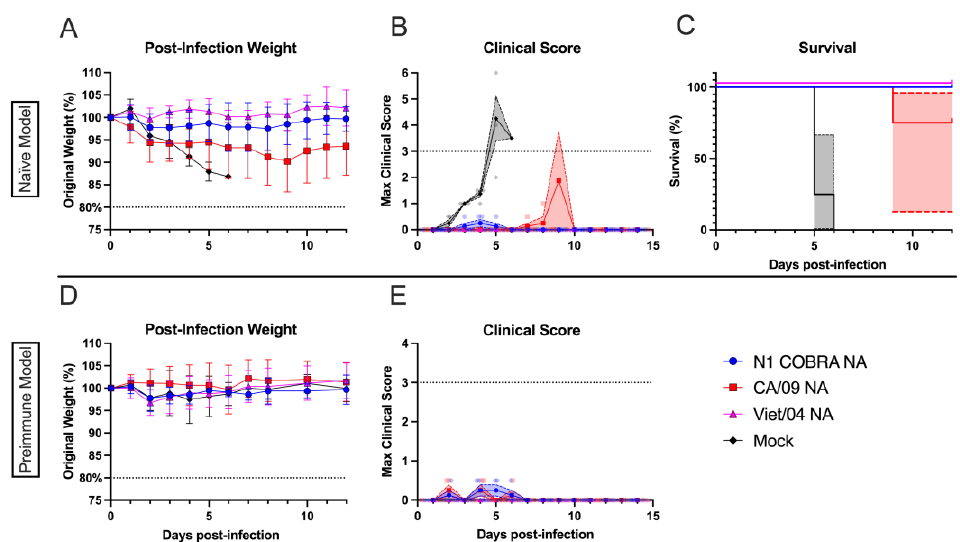
Figure 5. N1-I COBRA NA vaccine performed similarly to the Viet/04 NA vaccine in the naïve ferret model intranasally challenged with Viet/04 H5N1. ( A ) After infection with Viet/04, the weight during the infection was normalized to the percentage of the original starting weight before infection. ( B ) The maximum clinical scores from the morning and evening checks were displayed with a score of three or greater indicating clinical endpoint. Individual ferret clinical scores are shown with the line connecting the mean score and the range of the standard error of the mean shaded. ( C ) The survival percentage for naïve ferret model were determined for each vaccine group. The 95% asymmetrical confidence intervals are shown as shadow for the groups that did not have 100% survival. ( D ) Weights were also monitored for the Sing/86 H1N1 pre-immune group, in addition to the clinical signs. ( E ) Survival was 100% for all groups in the pre-immune vaccinated Viet/04 infection model. All error bars represent standard deviation. The minimum weight before clinical endpoint was 75%, with 80% denoting an increase in clinical scoring.